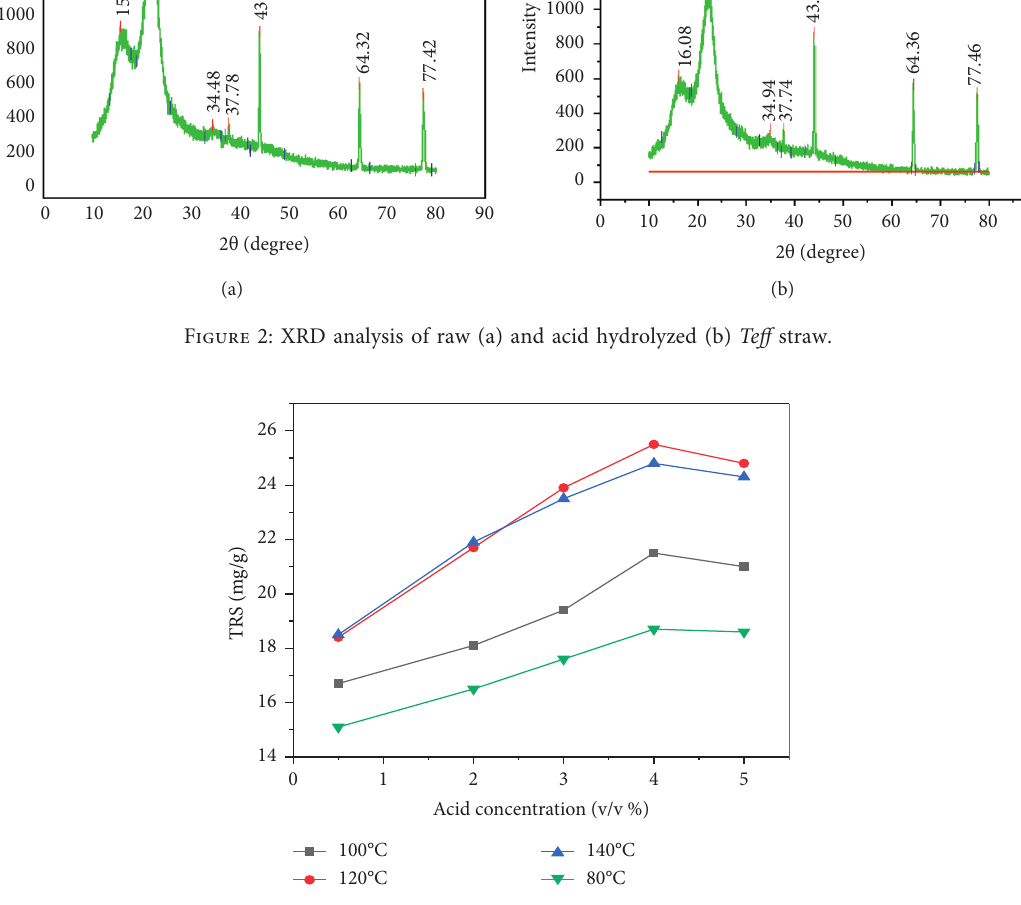
Figure 3: The effect of dilute sulfuric acid concentration and hydrolysis temperature on the yield of total reducing sugar (TRS) from Teff straw (hydrolysis time � 60min and solid to liquid ratio �